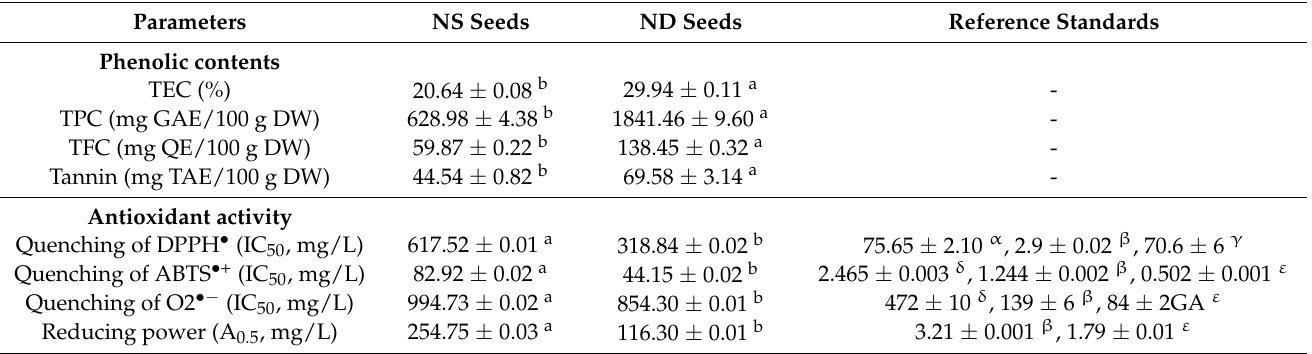
Table 3. Phenolic content and antioxidant activity of NS ( Nigella sativa L.) and ND ( Nigella damas- cena L.)